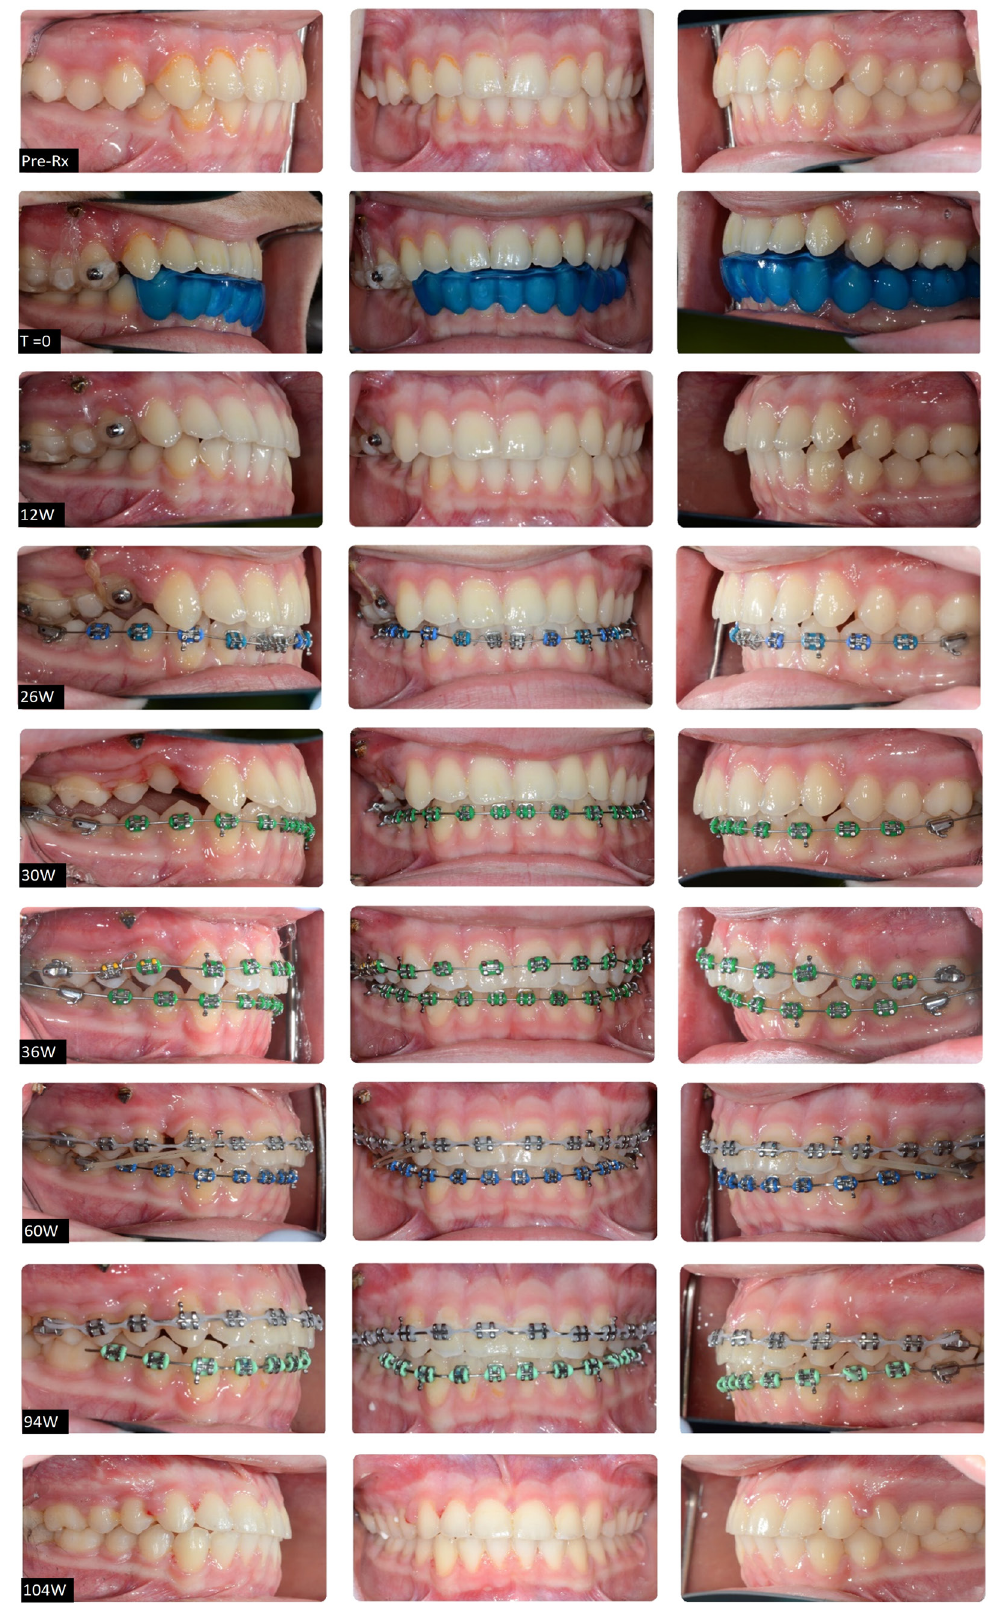
Figure 6. Treatment progression shown in frontal photographs (time-period in